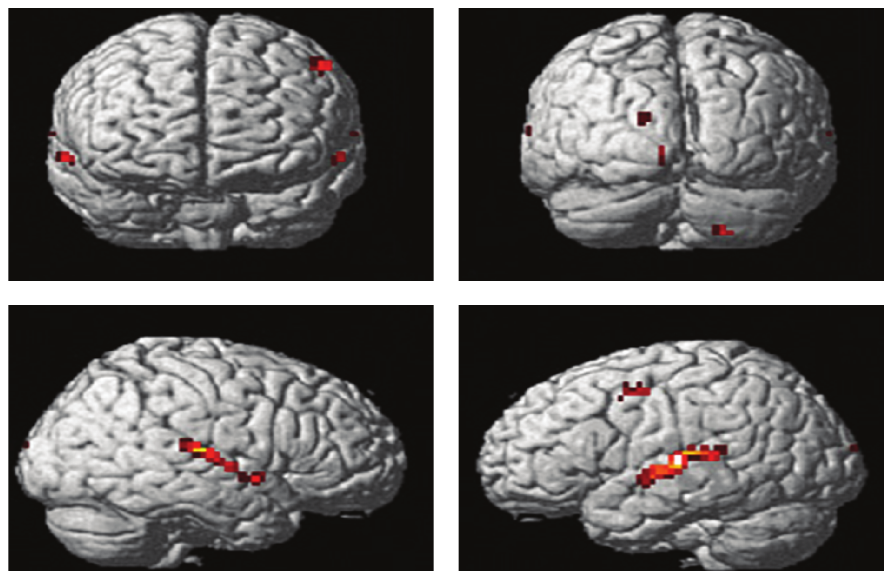
Figure 3: Listening question identification.